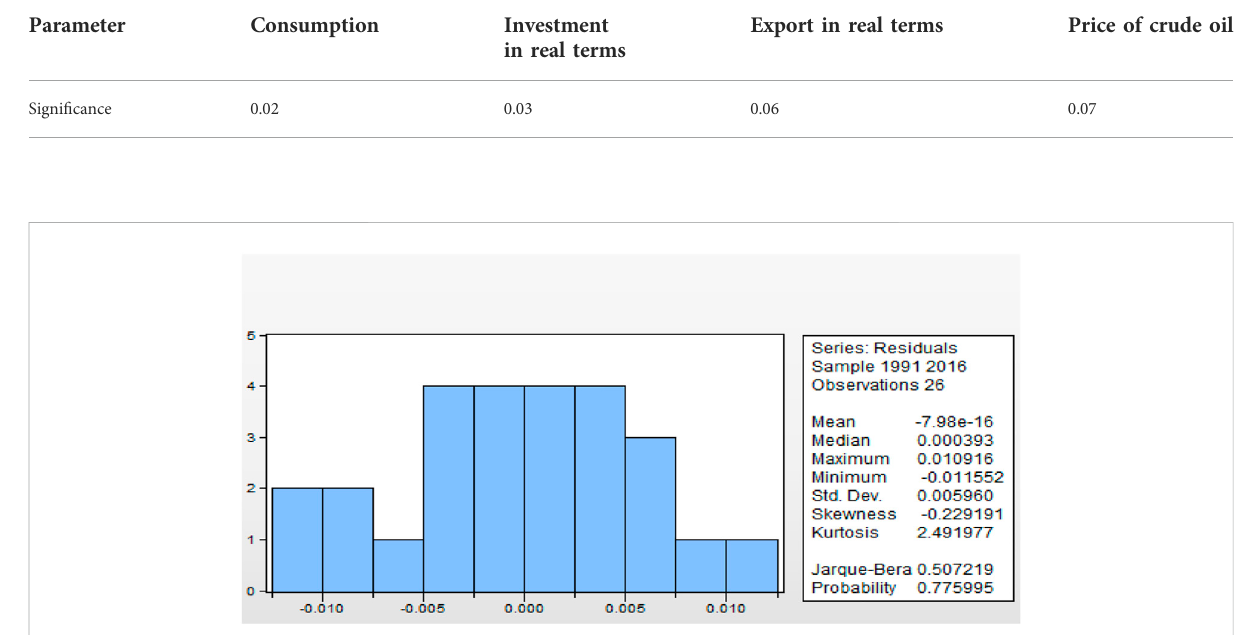
FIGURE 2 Check for normality by the Jarque – Bera